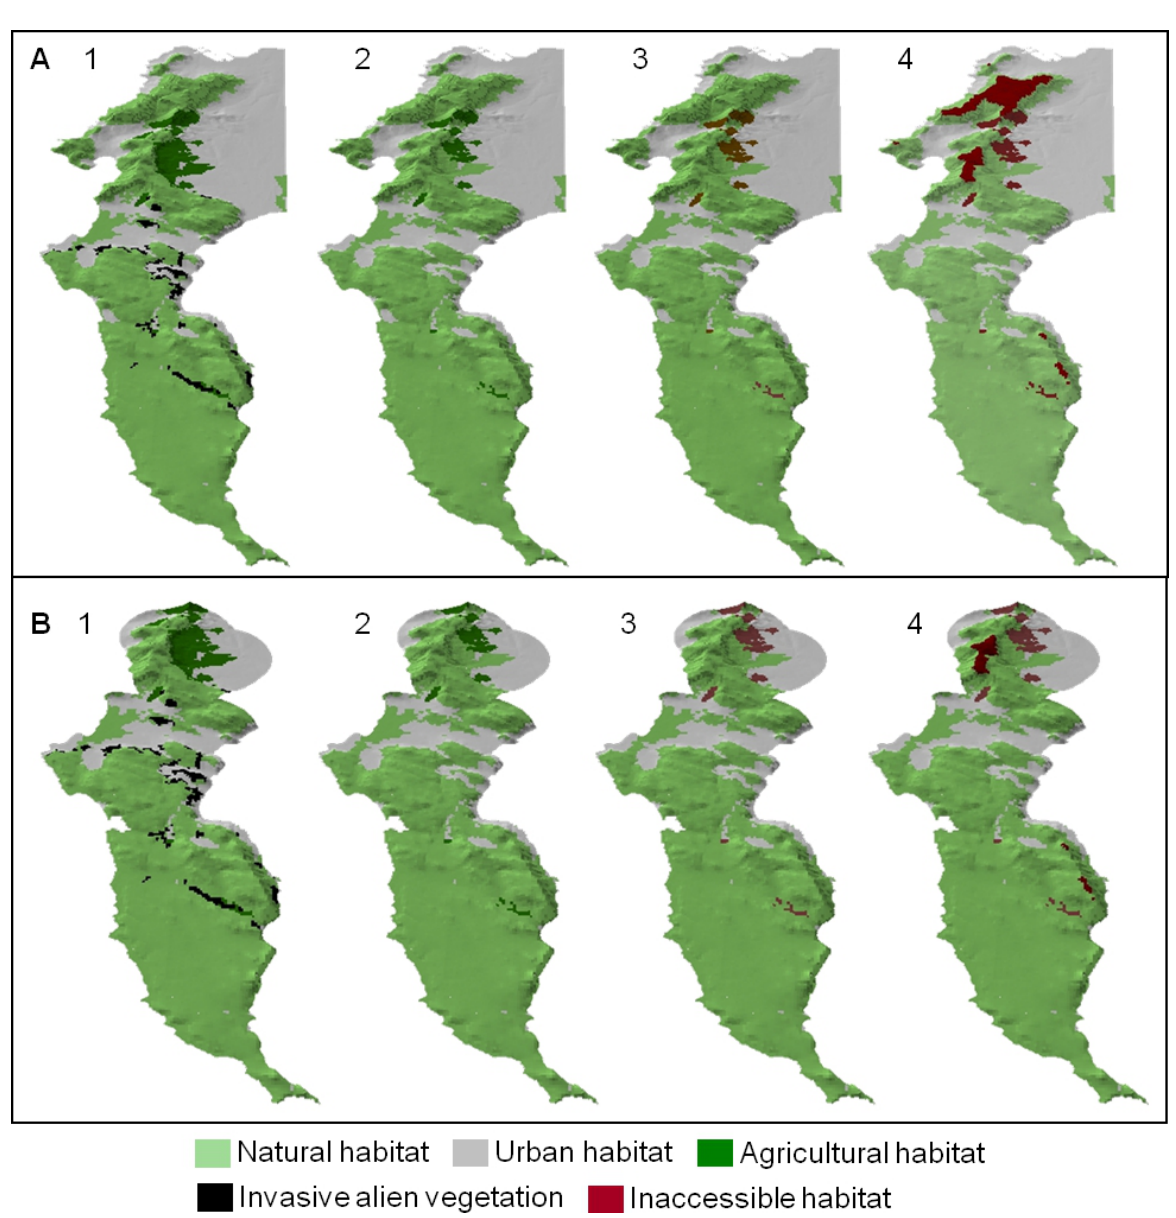
Fig. 2 . Three-dimensional maps of the Cape Peninsula showing eight hypothetical scenarios of available land for baboons. We combined these scenarios with two baboon density estimates to explore the total number of baboons that the Cape Peninsula could support. In both A and B, the total areas of available land decrease progressively from 1 to 4 in accordance with increasing access restrictions. A includes all land in the Cape Peninsula, while B includes only land immediately adjacent to troop home ranges and accessible within a one-day journey. In all scenarios baboons are denied access to urban habitat. In both A and B the details of Scenarios 1 to 4 are as follows: In Scenario 1 baboons are allowed unlimited access to natural habitat, invasive alien vegetation, and agricultural habitat. Scenario 2 is based on Scenario 1 but considers that all invasive alien vegetation and the Tokai plantation have been restored to natural habitat. Scenario 3 is based on Scenario 2 but denies baboons access to remaining agricultural habitat (vineyard, ostrich farm). Scenario 4 is based on Scenario 3 but includes only natural habitat £ 600 m (see methods for